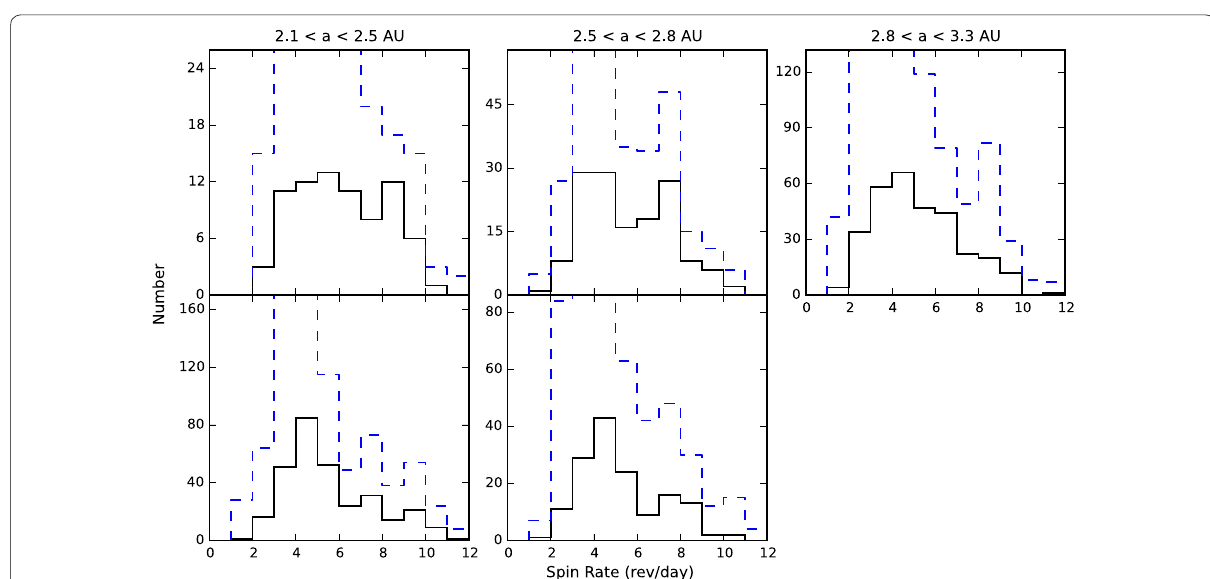
Fig. 7 Spin‑rate distributions of the 10‑min cadence surveys. The spin‑rate distributions for asteroids with diameter of 3 < D < 15 km ( upper ) and D < 3 km ( lower ) at inner ( left ), middle ( center ), and outer ( right ) main belt. The solid black line and blue dashed line are the original and de‑biased results, respectively. Note that the number of asteroids of D > 15 km and that of D < 3 km in outer main belt are too small to carry out meaningful statistics. This figure is reproduced from Chang et al.